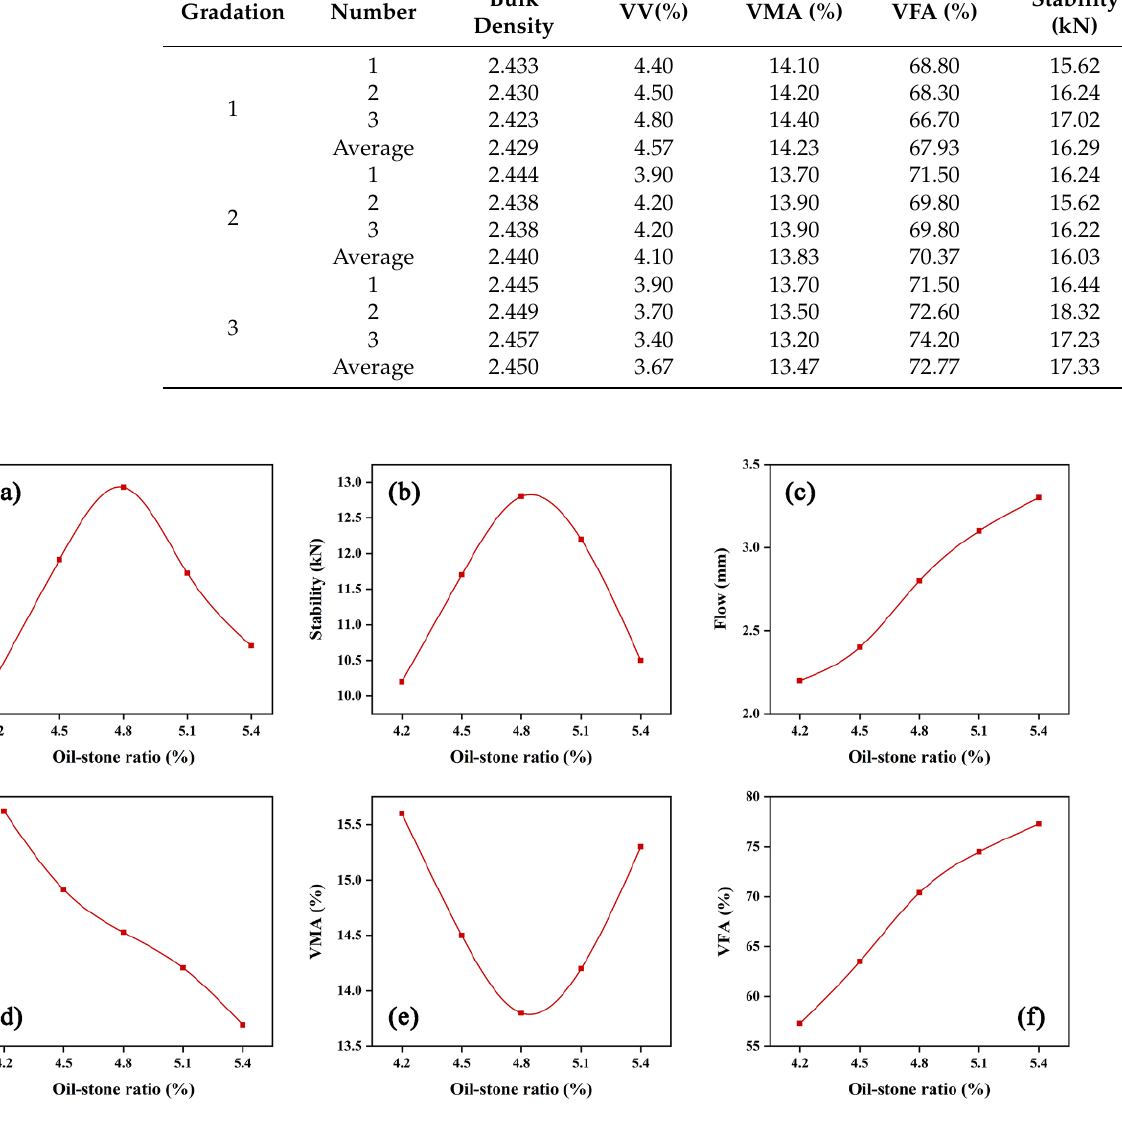
Figure 5. Marshall test results and volume parameters of AC-16 mixture: ( a ) bulk density; ( b ) stability; ( c ) flow; ( d ) VV; ( e ) VMA; and ( f ) VFA.